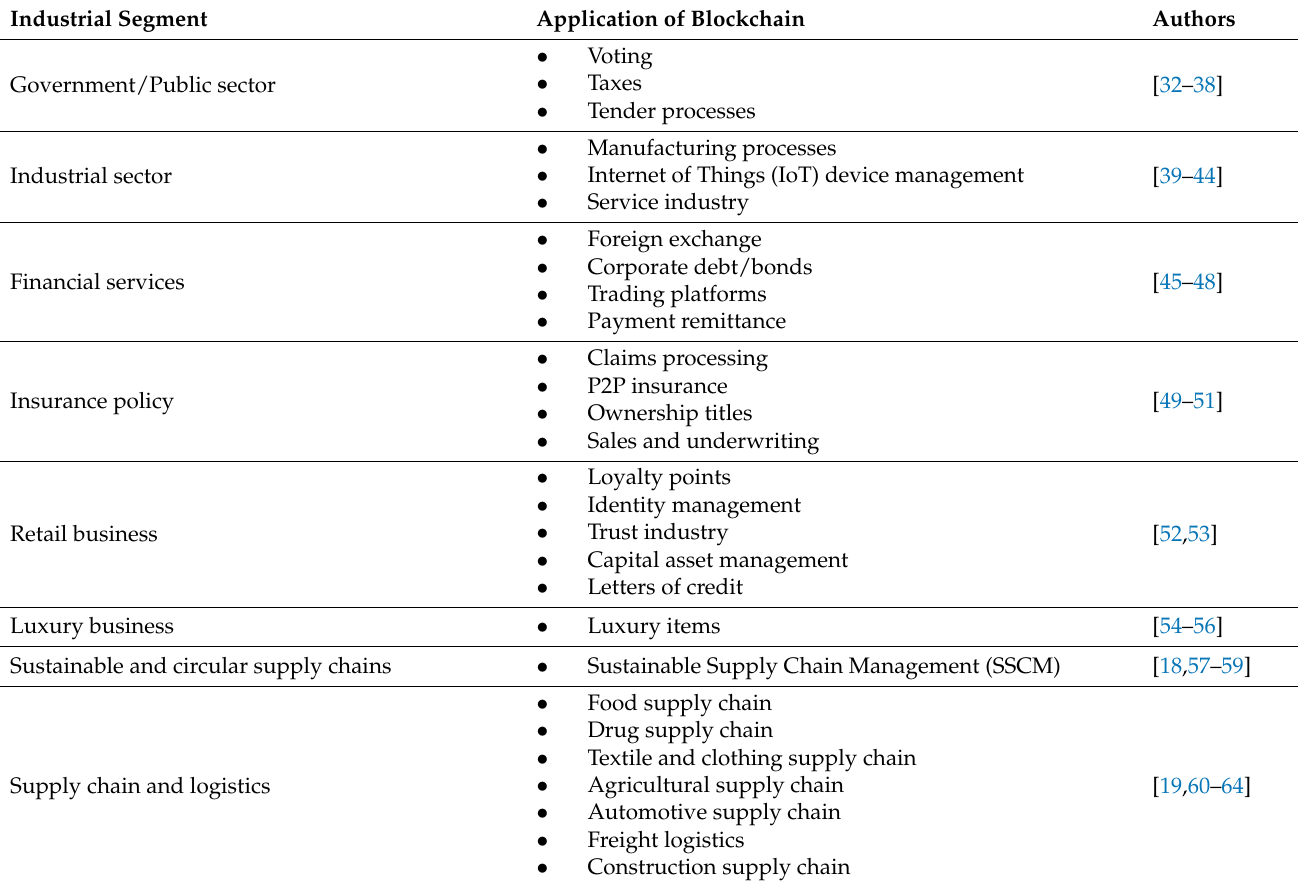
Table 1. The application of blockchain in various industrial